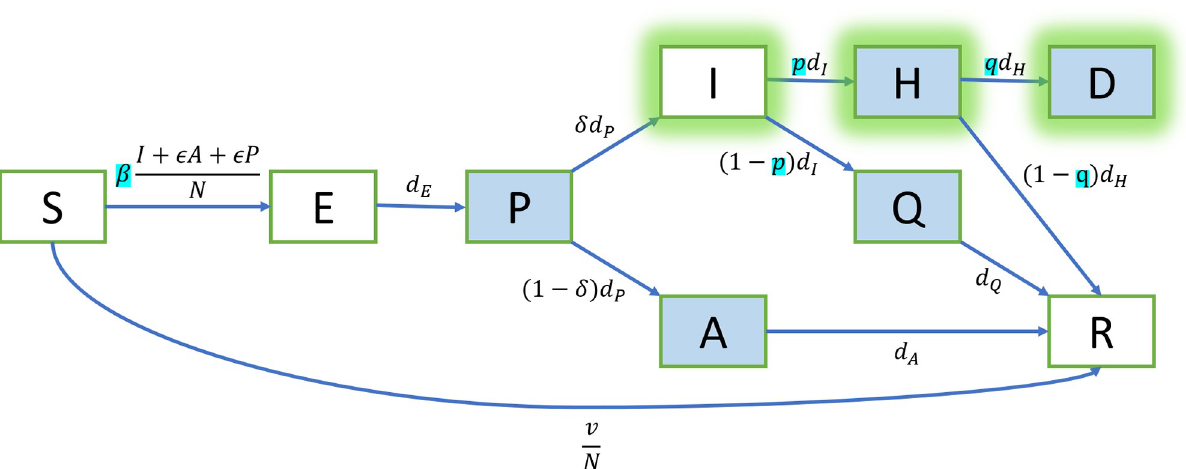
Fig 3. Transition diagram between epidemiological classes. We modify the classic SEIR model to include presymptomatic ( P ), asymptomatic ( A ), hospitalized ( H ), isolated ( Q ), and deceased ( D ) individuals. The given data are the inflows of symptomatic ( I ), hospitalized ( H ), and deceased ( D ) individuals. The parameters to estimate are ( β , p , q ). See Table 1 for the notations and the initial values. See Table 2 for the parameters. See Eq (1) for the corresponding ODE system.